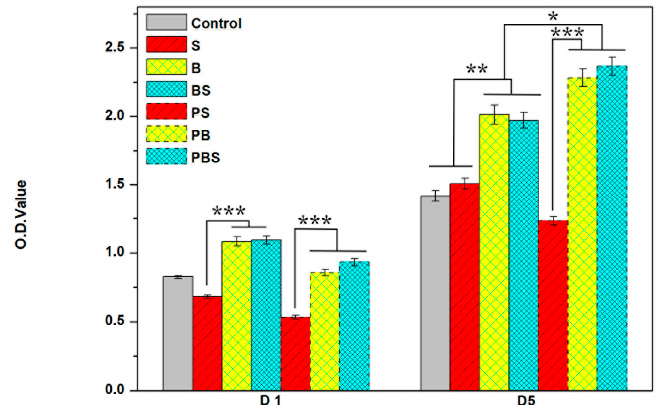
Figure 5. Cellular viability evaluation (CCK-8 assay) of MC3T3-E1 cells on different surface surfaces after one-day and five-day cultures.